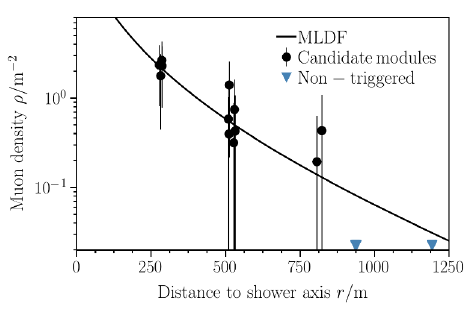
Figure 6. Example of a MLDF fit to a real event.